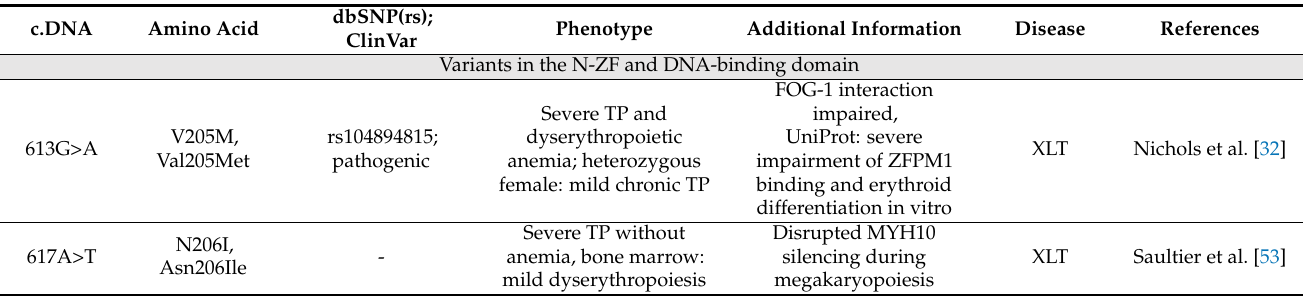
Table 4. Germline missense variants located in the zinc finger domains including the DNA-binding sites and the C-terminal region of GATA1